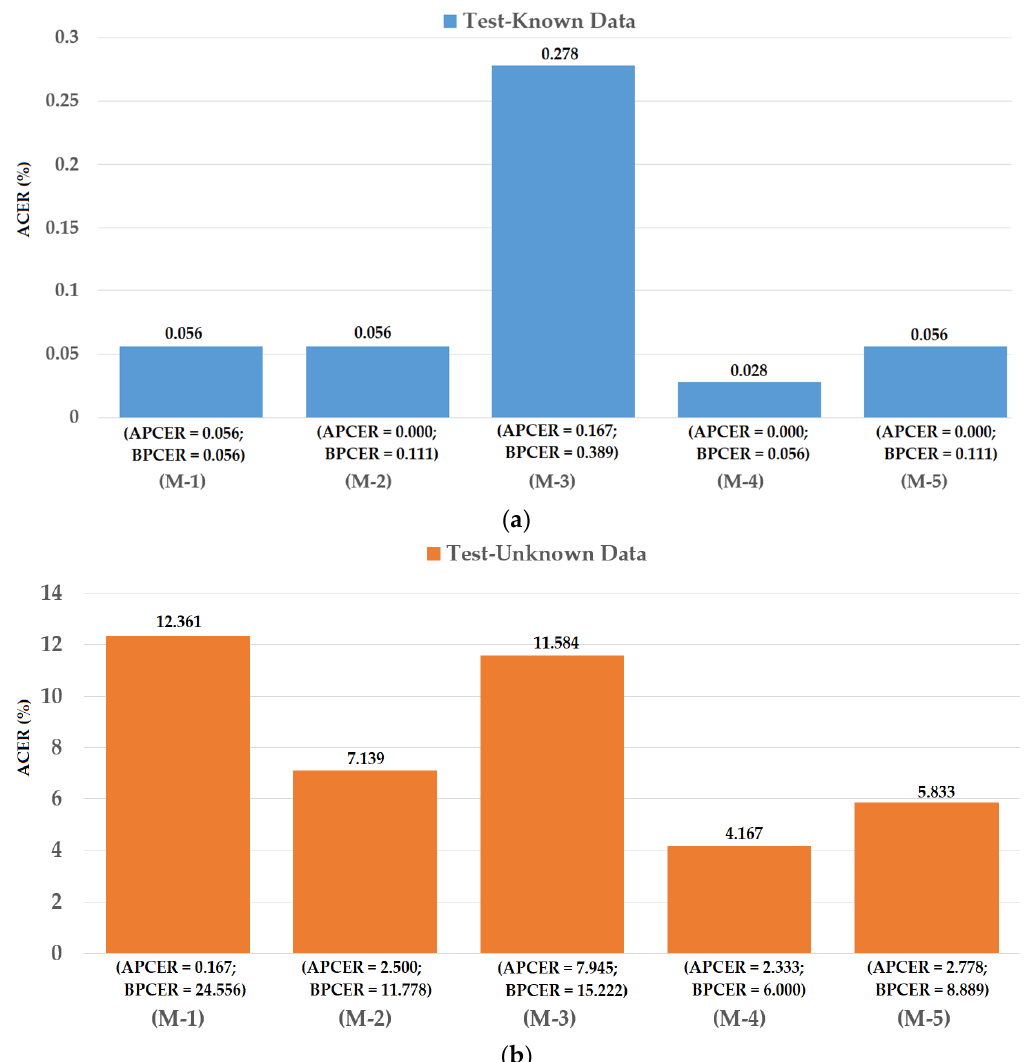
Figure 12. Detection errors of various iPAD methods using the first training-testing division method on ND2015 dataset: ( a ) Using Test-Known dataset; and ( b ) Using Test-Unknown dataset. Note: (M-1) Using CNN as Classifier; (M-2) Using CNN Features with PCA and Polynomial SVM Kernel; (M-3) Using MLBP Features with PCA and Polynomial SVM Kernel; (M-4) Using Feature Level Fusion with PCA and Polynomial SVM Kernel; and (M-5) Using Score Level Fusion with PCA and (Polynomial-Polynomial) SVM Kernels.